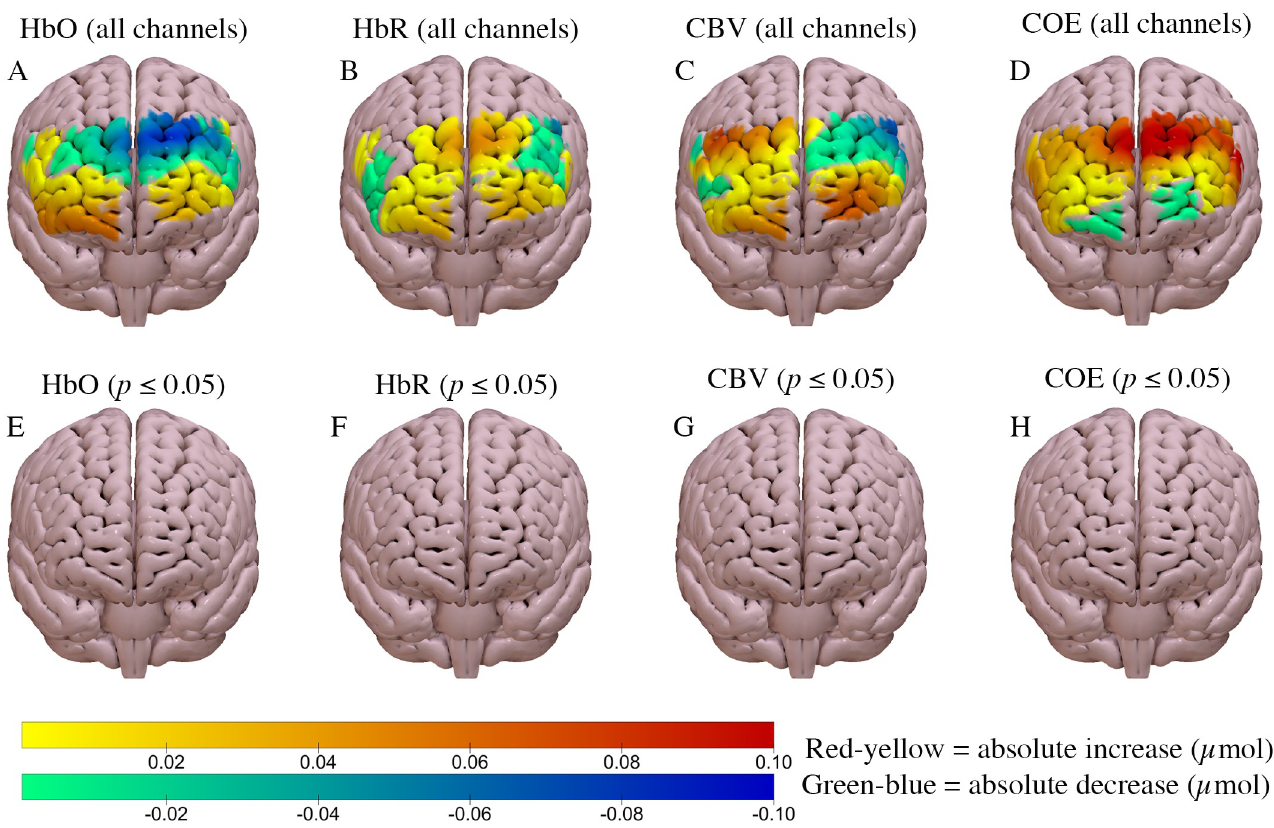
Fig 5. Between-scenario differences in the haemodynamic response. A, B, C, D = Δ HbO, Δ HbR, Δ CBV and Δ COE, respectively. E, F, G, H show data only for channels with statistically significant differences from baseline ( p � 0.05) for Δ HbO, Δ HbR, Δ CBV and Δ COE respectively. No statistically significant differences are present for panels E-H. Anterior brain view is shown. Note: The scale differs from that used in Figs 2 and